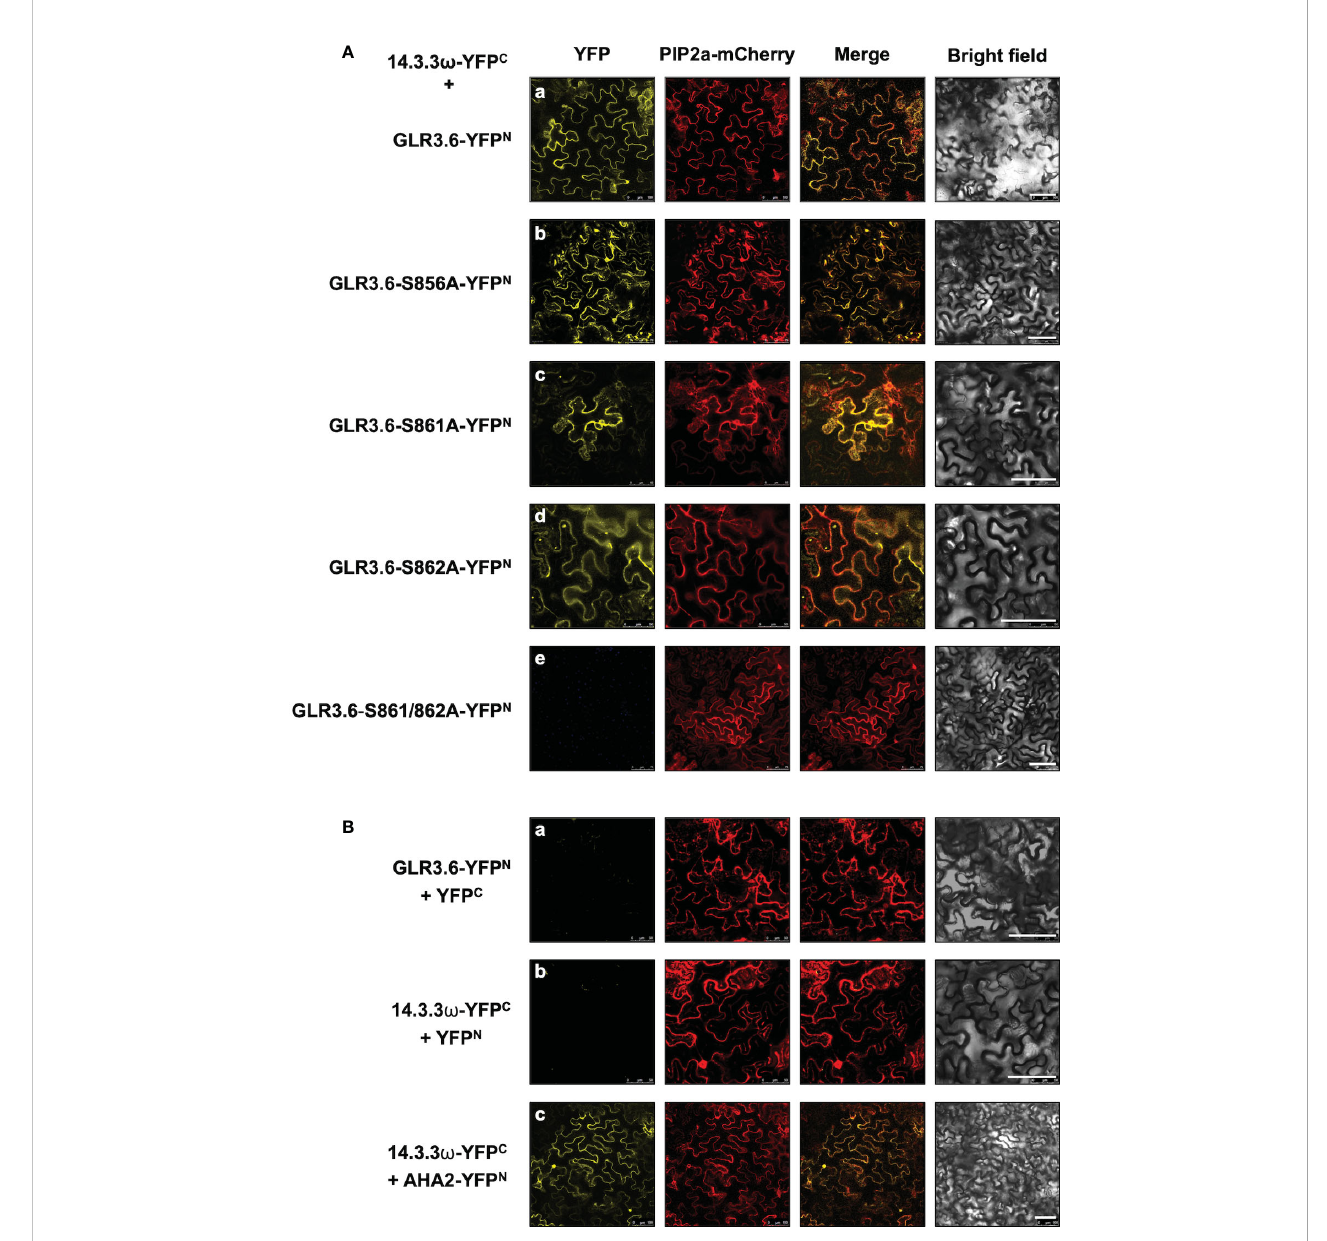
FIGURE 4 GLR3.6 interaction with 14-3-3 w in the plasma membrane was analyzed in tobacco cells. The bimolecular fl uorescence complementation (BiFC) assay was used to analyze the protein – protein interactions. Confocal microscopy was used to detect the reconstitute yellow fl uorescence protein (YFP) signal. (A) The 14-3-3 w -YFPC was co-expressed with (a) GLR3.6-YFP N , (b) GLR3.6-S856A-YFP N , (c) GLR3.6-S861A-YFP N , (d) GLR3.6-S862A-YFP N , or (e) GLR3.6- S861/862A-YFP N in tobacco cells. (B) The interactions of (a) GLR3.6-YFP N with YFP C and (b) YFP N with 14-3-3 w -YFP C were used as negative controls. (c) The well-known AHA2-YFP N interaction with 14-3-3 w -YFP C was used as positive control The PIP2a-mCherry was used as the plasma membrane marker. Scale bars = 100 m